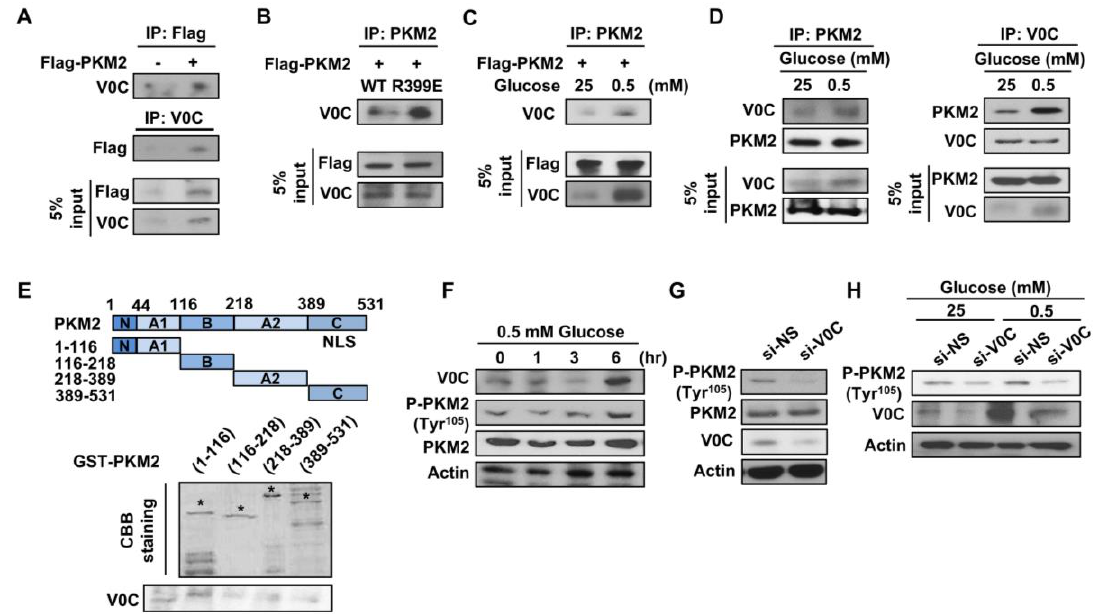
Figure 4. ATP6V0C interacts with PKM2 and increases PKM2 phosphorylation at Tyr 105 . ( A , B ) Reciprocal IP were performed in TE8 cells transfected with expression vectors such as Flag-PKM2 or the Flag-PKM2 mutant R399E. ( C ) Under high- or low-glucose conditions, co-immunoprecipitation assays were performed with an anti-Flag antibody in TE8 cells transfected with Flag-PKM2. ( D ) IP assays were performed with anti-ATP6V0C or anti-PKM2 in TE8 cells, followed by Western blotting. ( E ) GST pull-down assays were performed with GST alone or GST-PKM2 fusion protein expressed in bacterial cells. ( F ) TE8 cells were treated with 0.5 mM glucose during the indicating time point and, then, were analyzed for protein expression by Western blotting. ( G ) Western blotting of indicated proteins in TE8 cell lysates treated with NS or si-V0C. ( H ) TE8 cells were transfected with